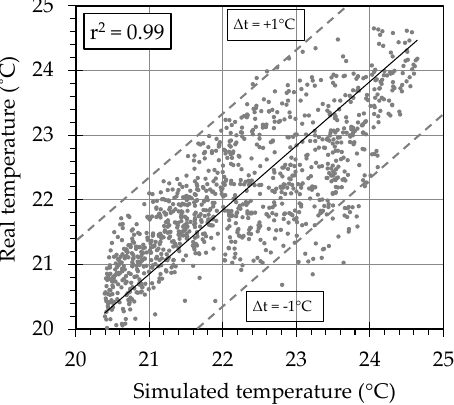
Figure 4. Coe ffi cient of determination for the best model Figure 4. Coefficient of determination for the best model calibrated.